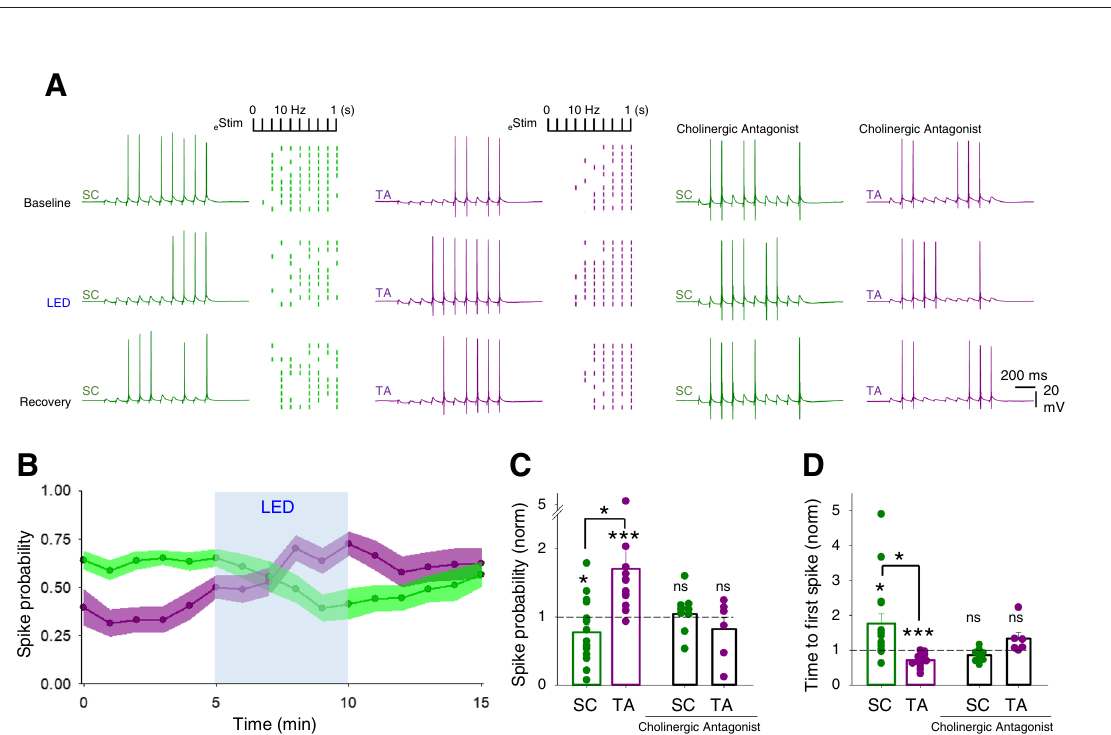
Fig. 5 Presynaptically located cholinergic receptors mediate TA EPSC reduction at CA1 pyramidal neurons. A Schematic illustrating GDP- β -S blockade of GPCR function by inclusion in the recording pipette. B , C GDP- β -S blocks Carbachol (CCh, 10 µ M)-induced depolarisation of membrane potential ( V m , left) and reduction of input resistance ( R in , right) (control, n = 21 from 13 mice, GDP- β -S, n = 7 from 3 mice, two-tailed unpaired t -tests, V m p = 0.025, R in p = 0.009). D Schematic illustrating pharmacological isolation of EPSCs from TA pathway and example traces showing depression by CCh (10 µ M) in the presence of GDP- β -S. E Schematic illustrating the putative role of GABA spillover from neighbouring synapses on presynaptic TA pathway terminals and example traces showing depression of EPSCs by CCh in the presence of GABA receptor antagonists picrotoxin (PTX, 50 µ M) and CGP55845 (5 µ M). F Schematic illustrating putative action of retrograde endocannabinoids on presynaptic TA pathway terminals and example traces showing depression of EPSCs by CCh in the presence of CB1 receptor antagonist AM251 (1 µ M) and GABA receptor antagonist picrotoxin (50 µ M). G , H Quanti fi cation of EPSC depression by CCh ( G CCh, n = 21 from 13 mice, p <0.0001; CCh + GDP- β -S, n = 7 from 3 mice, p <0.0001; CCh + PTX + CGP, n = 9 from 4 mice, p <0.0001; CCh + PTX + AM251, n = 12 from 4 mice, p <0.0001; CCh vs CCh + GDP- β -S, p = 0.31; CCh vs CCh + PTX + GDP, p = 0.26; CCh vs CCh + PTX + AM251, p = 0.002) and change in PPR ( H CCh, n = 21 from 13 mice, p = 0.006; CCh + GDP- β -S, n = 7 from 3 mice, p = 0.047; CCh + PTX + CGP, n = 9 from 4 mice, p = 0.007; CCh + PTX + AM251, n = 12 from 4 mice, p = 0.017; CCh vs CCh + GDP- β -S, p = 0.18; CCh vs CCh + PTX + GDP, p = 0.31; CCh vs CCh + PTX + AM251, p = 0.79; inter-group comparisons one-way ANOVA with post hoc Bonferroni correction. Within-group comparisons two-tailed paired t -test). Data are mean±SEM; ** p <0.01, * p <0.05. Source data are provided as a Source Data fi le.